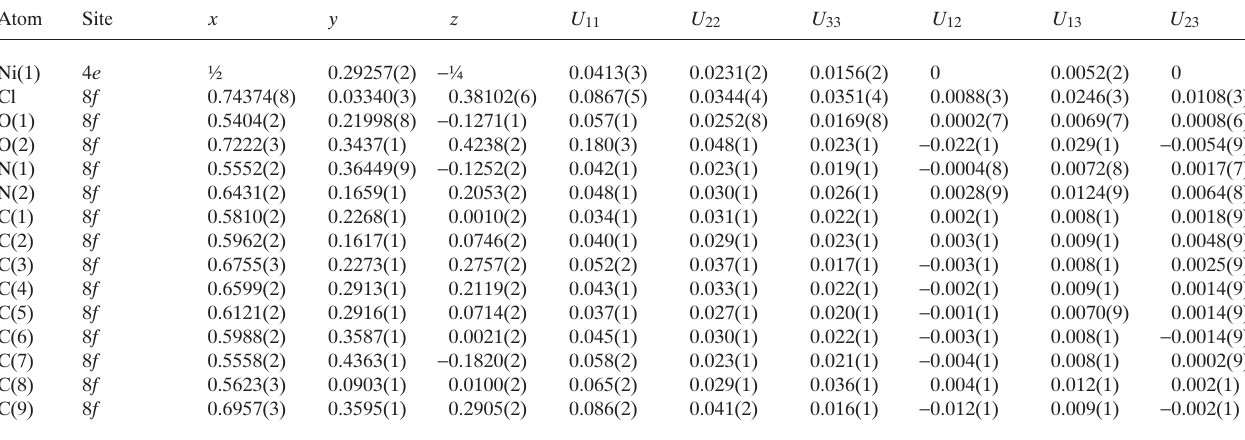
Table 3. Atomic coordinates and displacement parameters (in Å 2 ) .